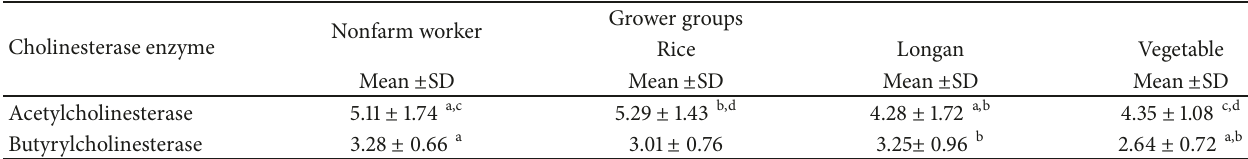
Table 3: Cholinesterase activity (mean and standard deviation (SD)) of nonfarm workers and grower groups. Cholinesterase enzyme